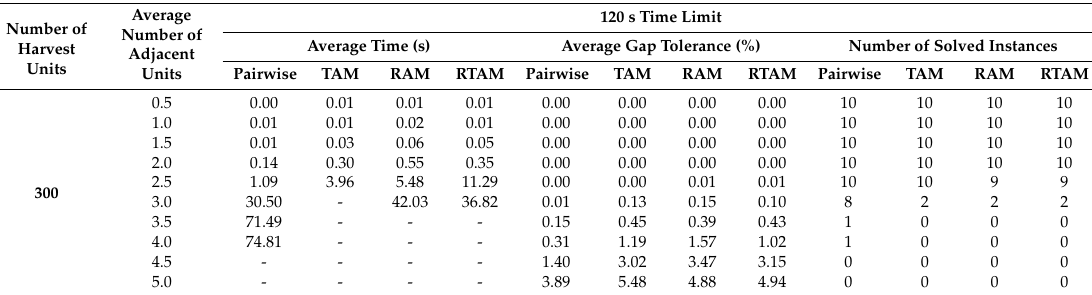
Table 8. Solving time, gap tolerance and number of solved instances for 120 s time limit and 300 harvest units.